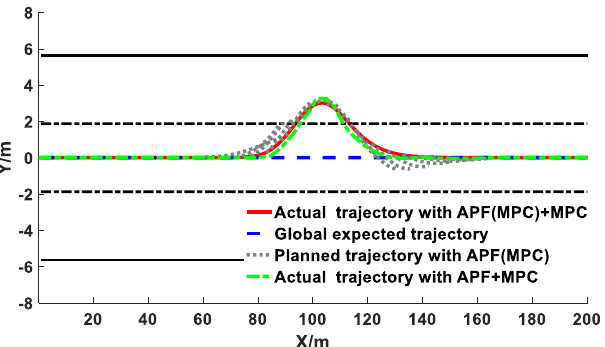
Figure 15. Co-simulation results of obstacle avoidance trajectory planning under 40 km/h.